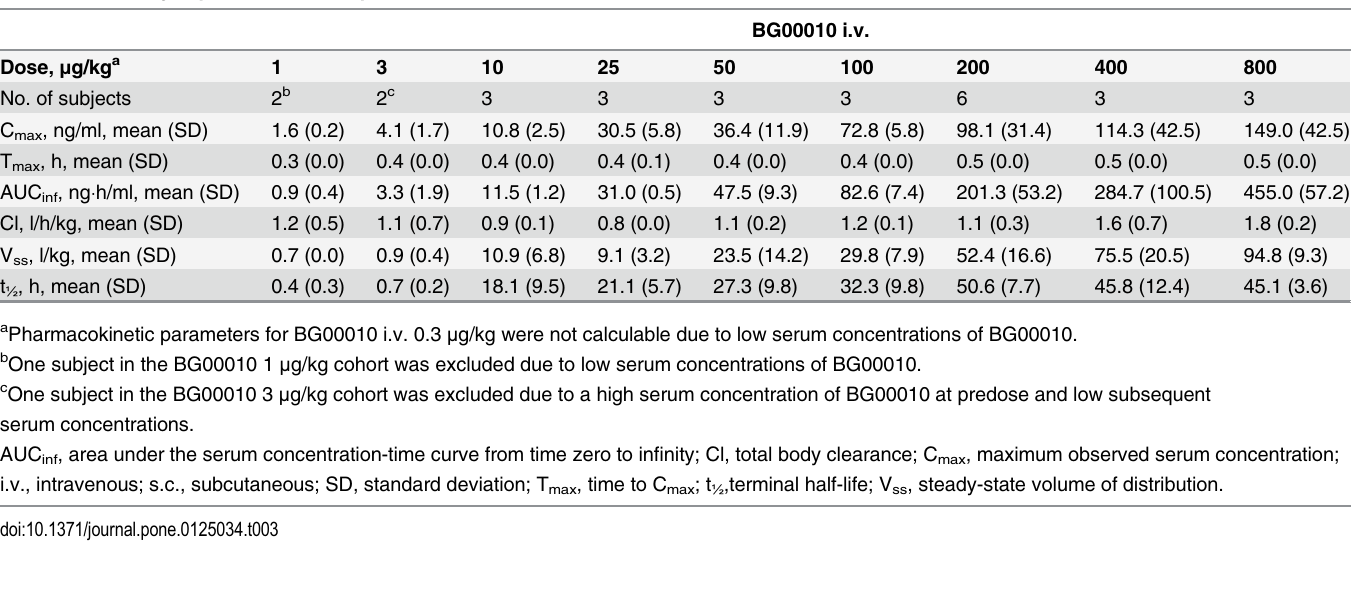
Table 3. Summary of pharmacokinetic parameters of i.v. BG00010.